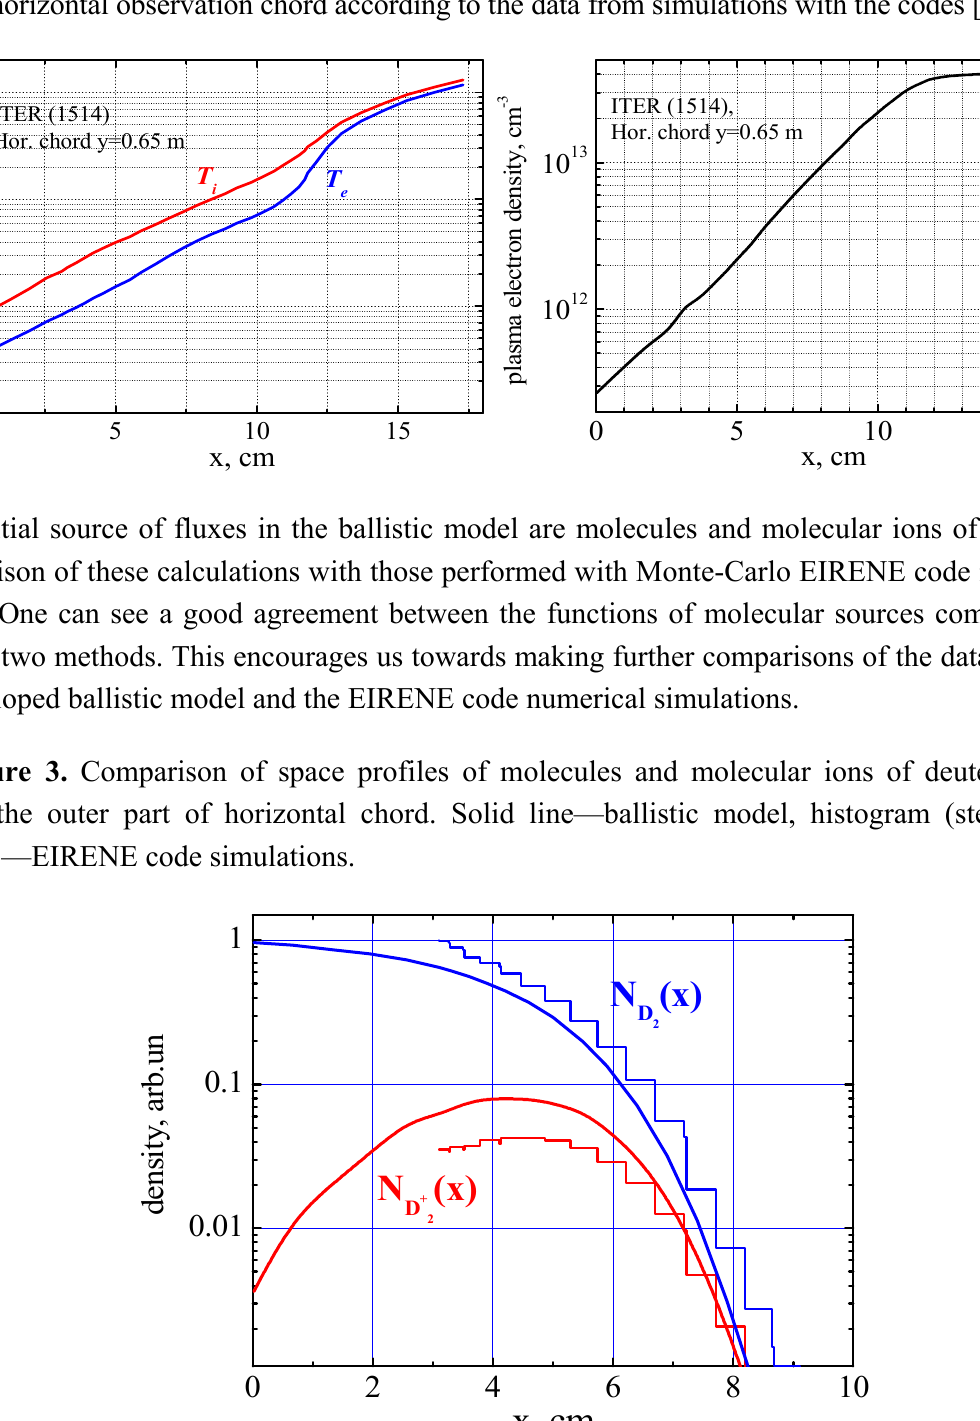
Figure 2. Electron and ion temperature ( left ) and electron (and ion) density ( right ) along the horizontal observation chord according to the data from simulations with the codes [4].